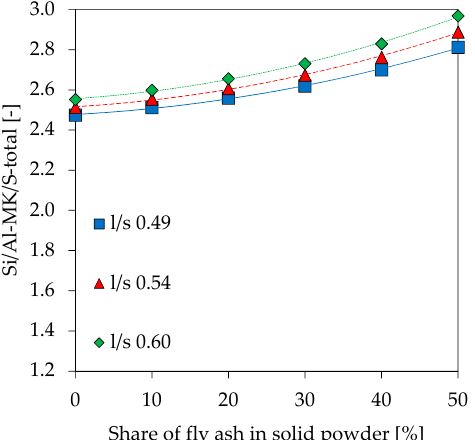
Figure 16. Theoretical Si/Al ratio, calculated with amorphous Si and Al, including fly ash (Si/Al-MK/FA/S).